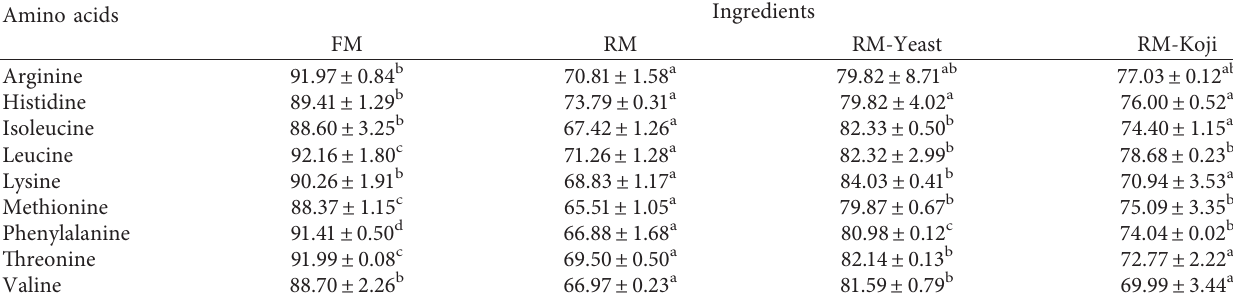
Table 4: Apparent availability coefficients (%) of amino acids in test ingredients for Japanese flounder ∗ . Amino acids